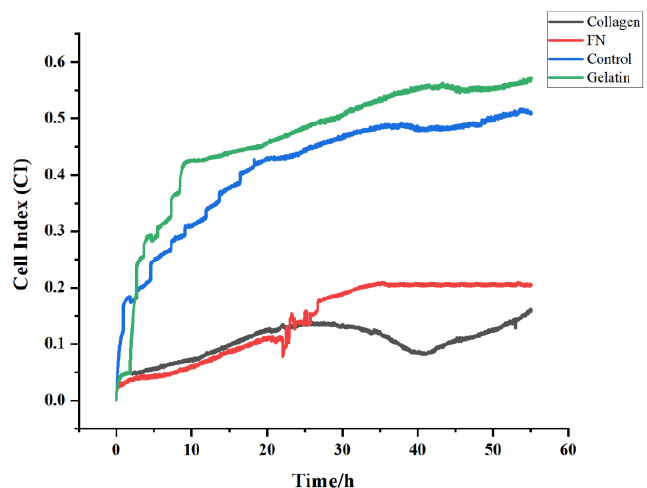
Figure 3. Comparison of the cell indices under different cell modification schemes.